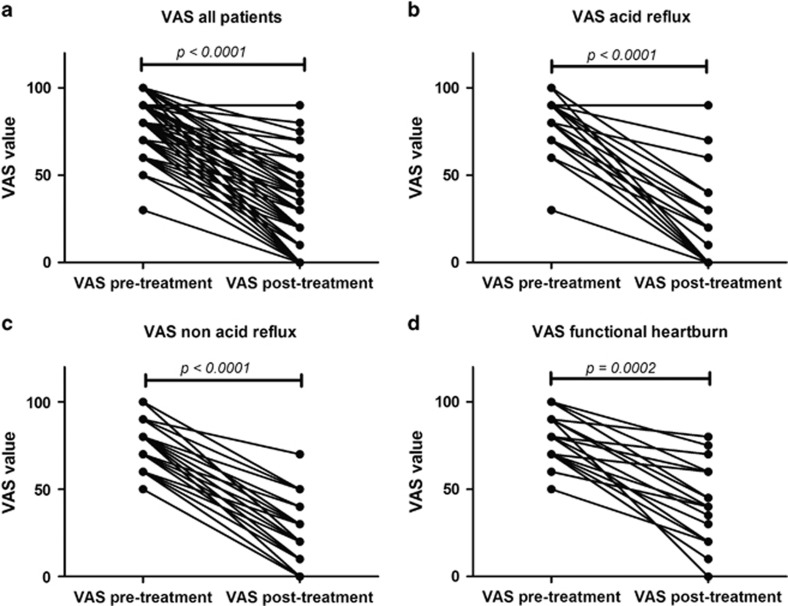
Variations in VAS score before and after the tailored treatment, for all patients (a) and patients with acid reflux (b), non-acid reflux (c) and functional heartburn (d)